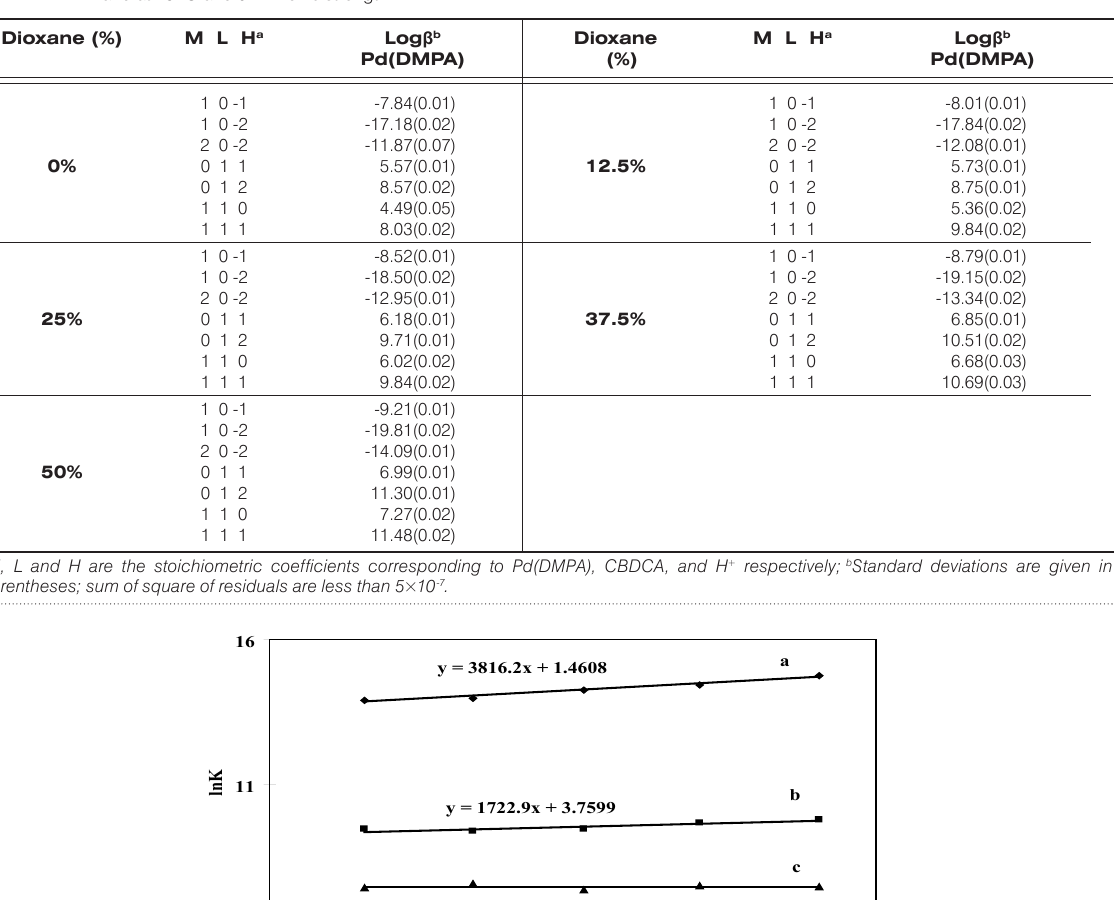
O) ] 2+ with CBDCA at different concentrations of solvent (dioxane) 2 2